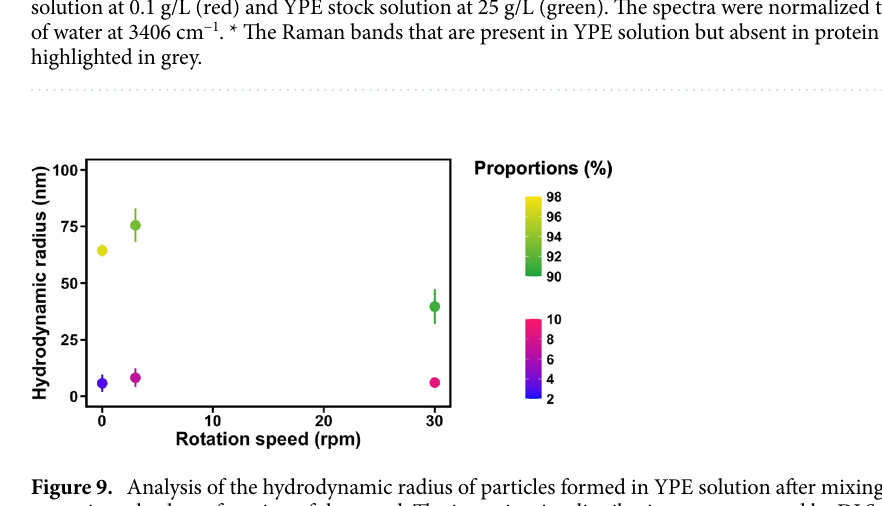
Figure 9. Analysis of the hydrodynamic radius of particles formed in YPE solution after mixing in PP tubes on a rotating wheel as a function of the speed. The intensity size distribution was measured by DLS after filtration of the solutions at 1.2 µm to remove the larger aggregates. The percentage of each population (in intensity) is coded in